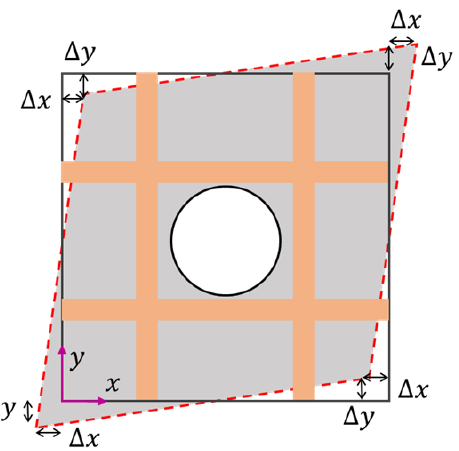
Figure 13. Composite stiffened plate under in-plane shear